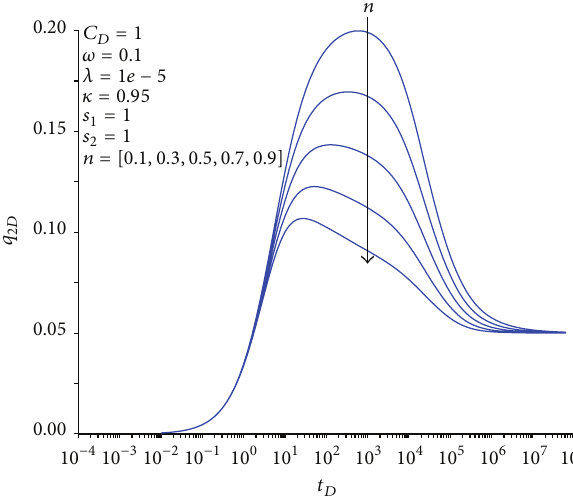
Figure 4: Dimensionless flow-rate for the second layer.